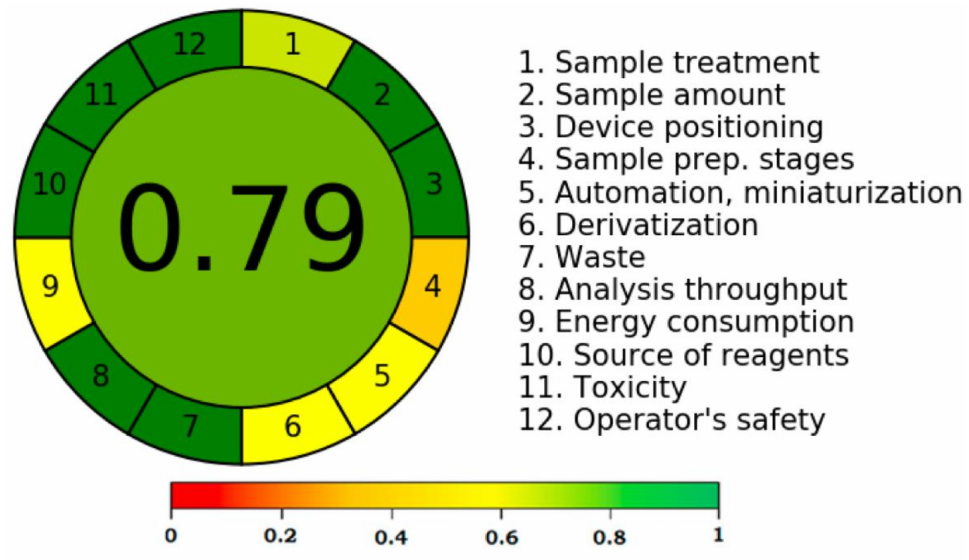
Figure 7. Analytical GREEnness (AGREE) scale for the greener normal-phase HPTLC